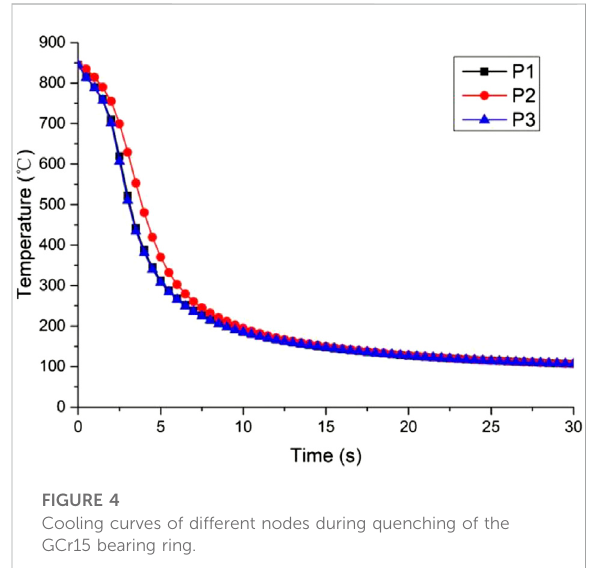
FIGURE 4 Cooling curves of different nodes during quenching of the GCr15 bearing ring.